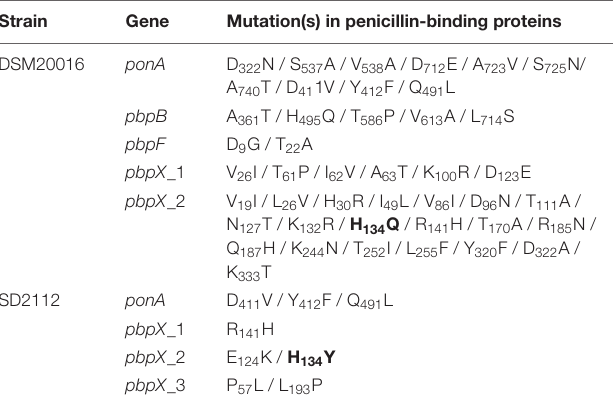
Strain Gene Mutation(s) in penicillin-binding